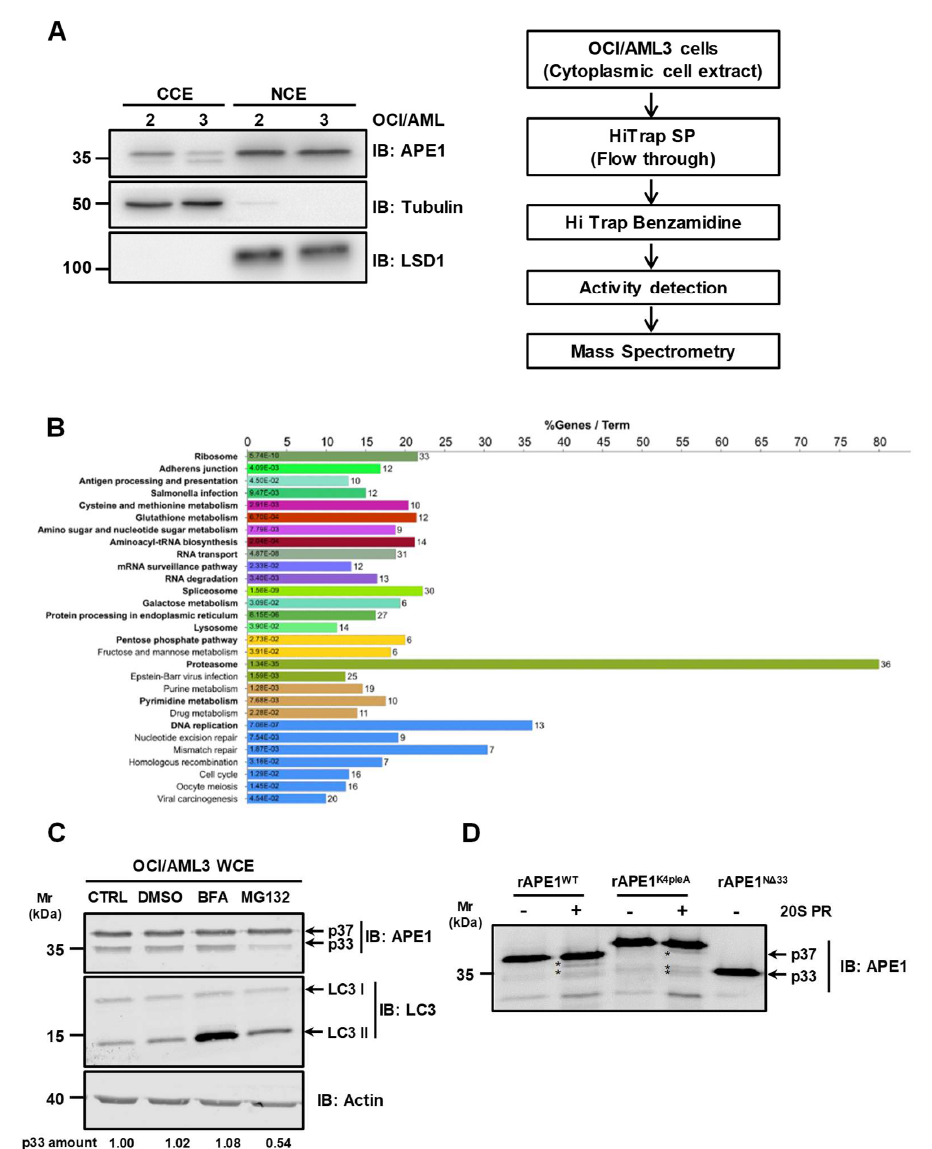
Figure 4. The 20S proteasome is involved in APE1 cleavage. ( A ) Purification strategy used for the isolation of the protease(s) responsible for APE1 truncation in OCI / AML3 cells. Schematic depiction of the workflow used in this study. A OCI/AML3 cytoplasmic lysate (≈ 10 8 cell equivalents) was loaded onto a HiTrap SP Sepharose column. The resulting flow-through, enriched for negative charged proteins, was loaded on a HiTrap Benzamidine column; serine-proteases retained were then eluted and each fraction was screened for protease activity. Positive fractions were subjected to proteomic analysis for protein identification. Representative Western blotting analysis on nuclear and cytoplasmic